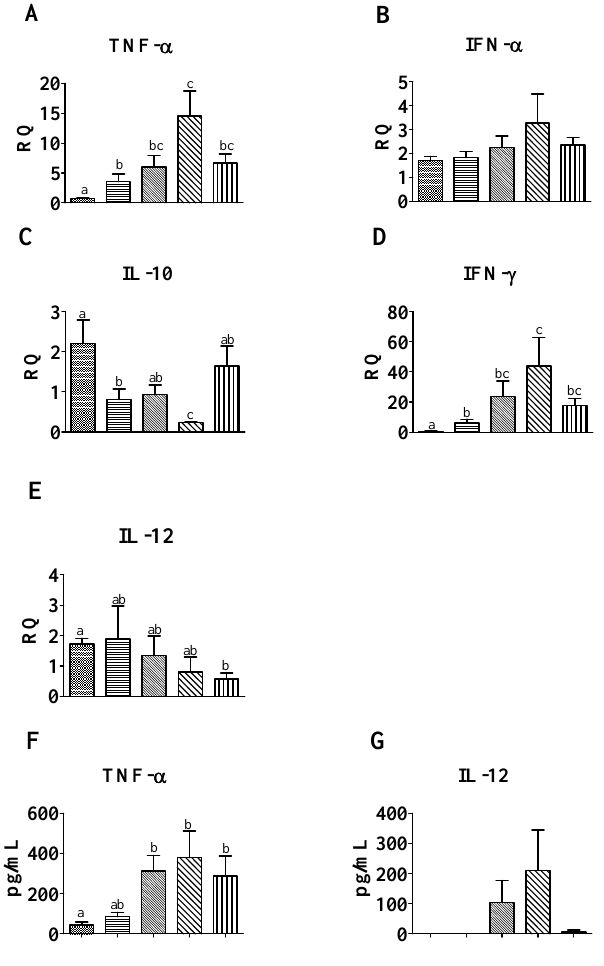
Figure 4. mRNA and protein expression of cytokines in peripheral blood mononuclear cells (PBMCs) from vaccinated pigs at 21 dpv. Analysis of interferon ‐ alpha (IFN ‐α ), IFN ‐γ , interleukin (IL) ‐ 10, IL ‐ 12, and tumor necrosis factor ‐ alpha (TNF ‐α ) mRNAs ( A – E ) and protein ( F , G ) expression levels of various cytokines in PBMCs after 72 h culture. Changes in mRNA expression were evaluated by quantitative real time polymerase chain reaction (qRT ‐ PCR). Relative quantification of mRNA expression was estimated using the 2 −ΔΔ Ct method, and IL ‐ 12 and TNF ‐α protein levels were quantified in PBMC supernatants by ELISA. Bars showing different letters represent values significantly different from each other ( p < 0.05). RQ: Relative Quantification.